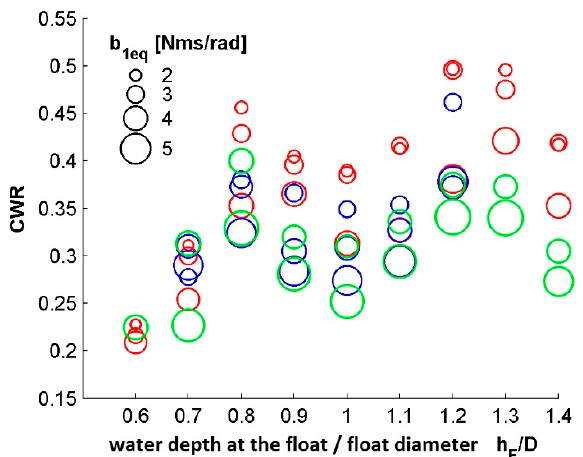
Figure 9. CWR of EDS as a function of flat damping b 1eq , distance between paddle and float d P-F / D , water depth at the float h F / D . Red circles, d P-F /D = 0.8; blue circles, d P-F /D = 1.1; green circles d P-F /D = 1.4. Wave A.